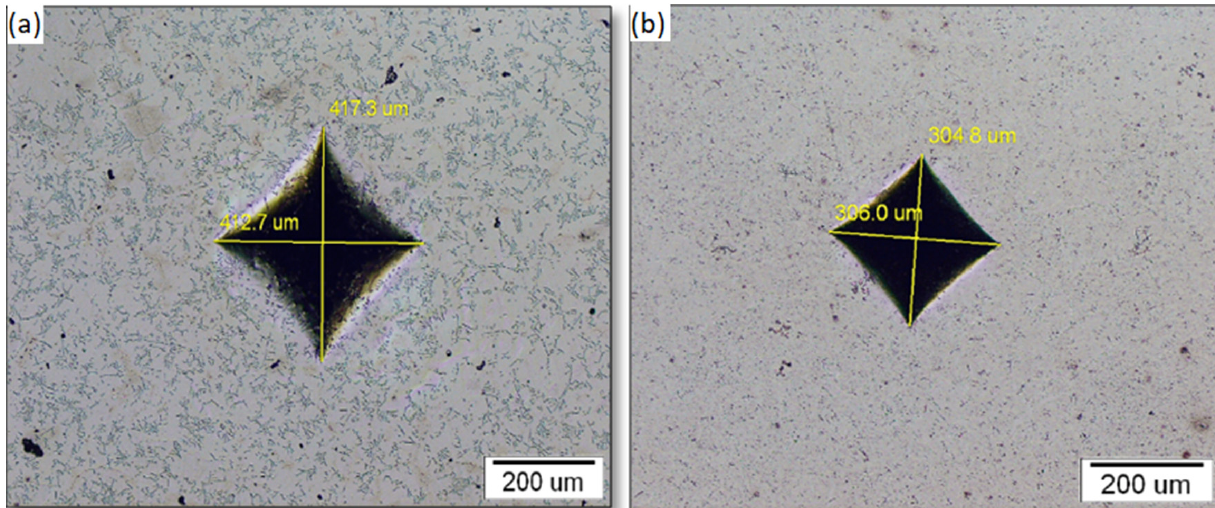
Figure 4. Indentation imprint: ( a ) NiTi-1 sample; ( b ) NiTi-2 sample.